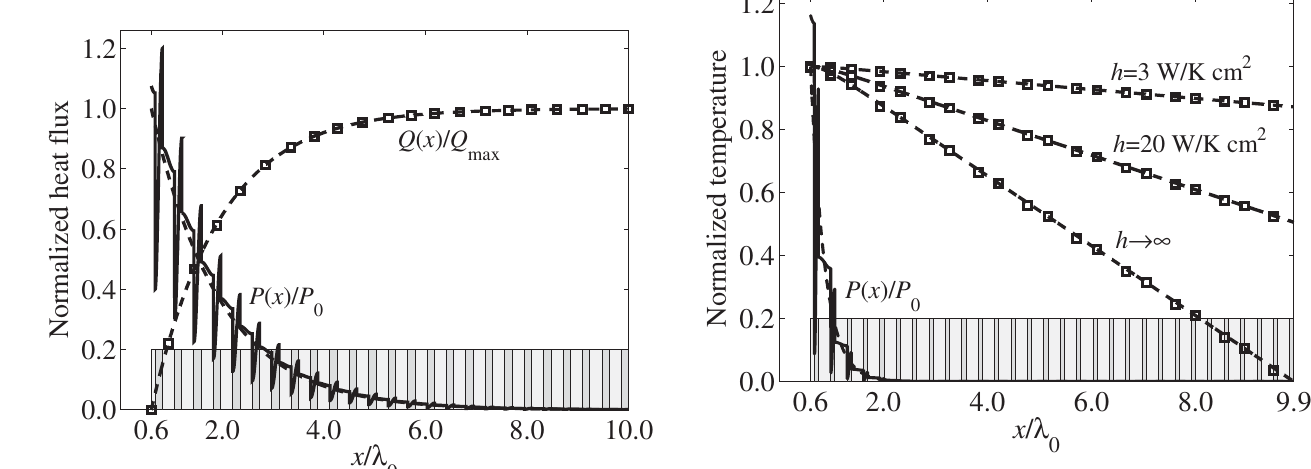
FIG. 6. Heat-flux profile in the silica-zirconia structure, the parameters of which are given in Table II. The dashed line is the approximate curve, and the exact solution is indicated by square markers. The dissipated power profiles, approximate (dashed line) and exact (solid line), are also plotted. The two quantities are normalized by their maximal approximate value.